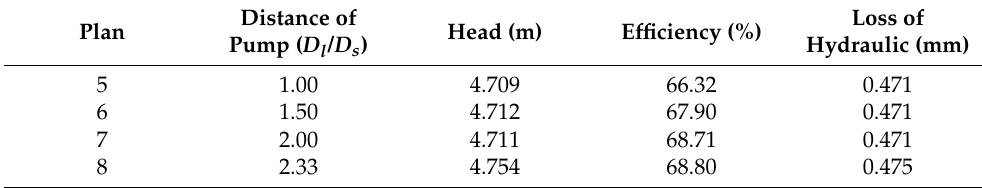
Table 5. CFD performance analysis of the research program.